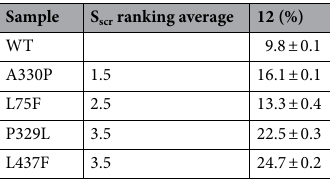
Table 2. ( S )-(−)-Limonene ( 1 ) C6 oxidation activity of the proposed mutants determined by MD simulation.